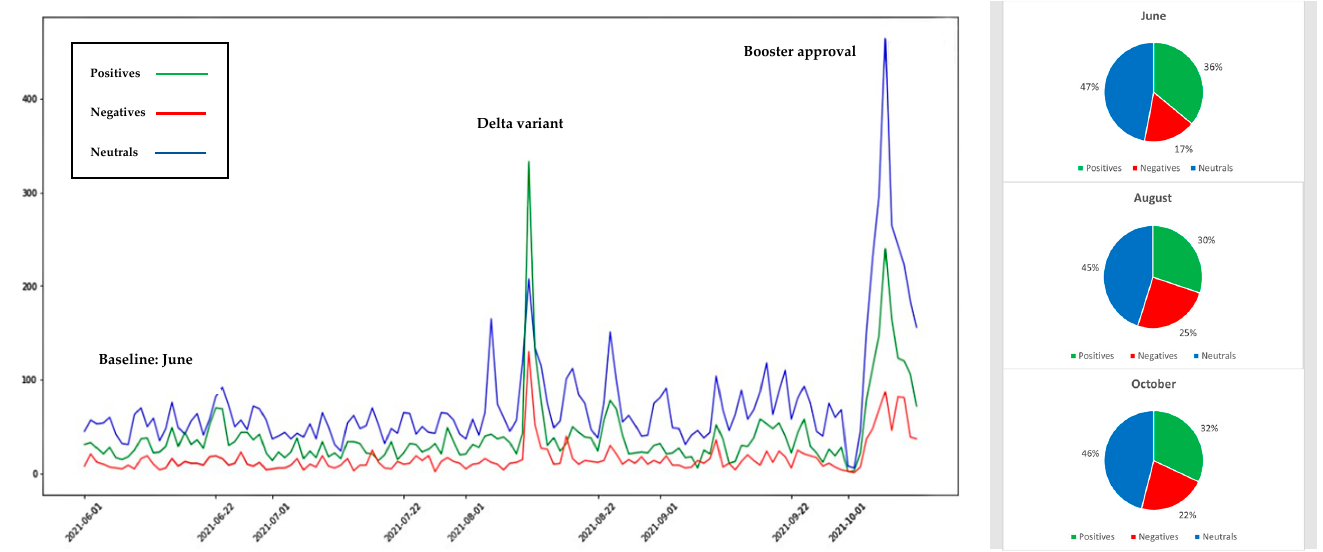
Figure 6. Sentiment analysis results of tweets related to Moderna Figure 6. s entiment analysis results of tweets related to Moderna vaccine.